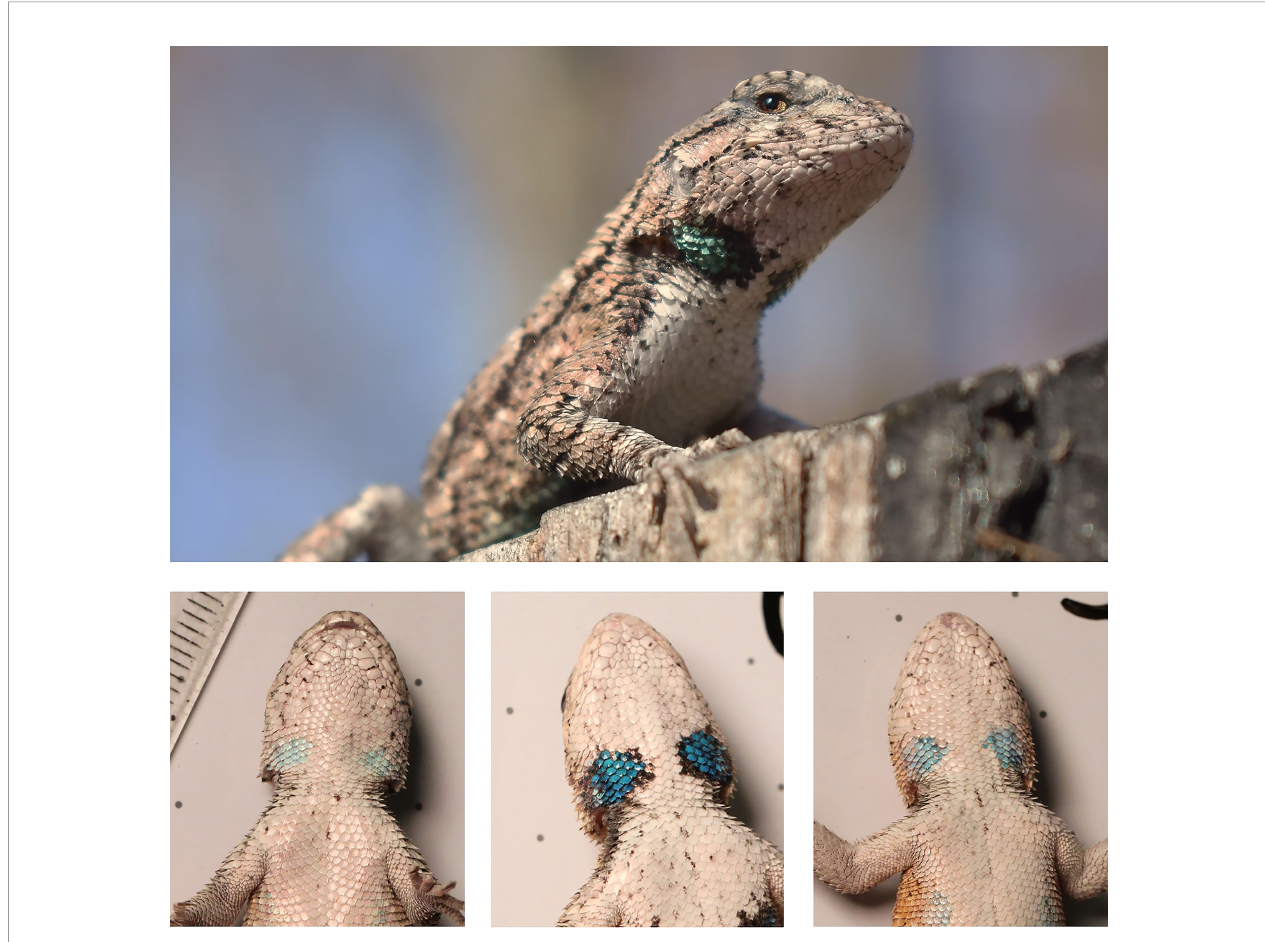
FIGURE 1 | Above: eastern fence lizard in early adulthood in early adulthood and released after the conclusion of this study; below: representative photos of mature offspring used in this study. Left: female; center: male with highly saturated badges; right: male with low saturation badges. All lizards were approximately 323 days of